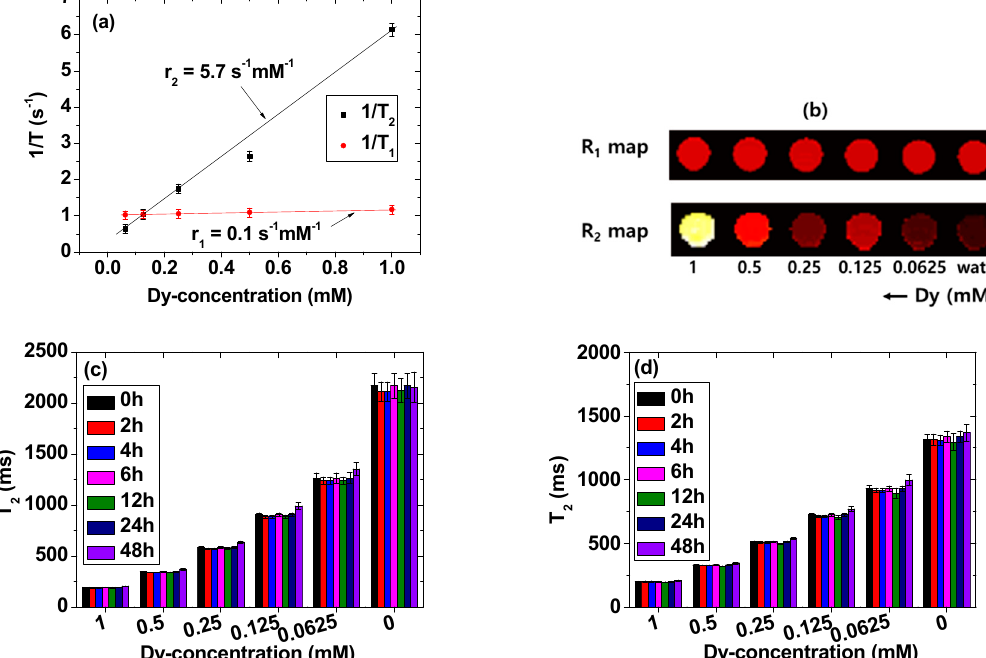
Figure 7. Relaxometric properties of the DYO@C nanoparticles in an aqueous solution. ( a ) Plots of 1/T 1 and 1/T 2 as a function of Dy-concentration in the 3.0 T MR field and the slopes correspond to r 1 and r 2 values, respectively; ( b ) R 1 and R 2 map images as a function of Dy-concentration, showing dose-dependent contrast enhancements in the R 2 map images but not in the R 1 map images; and T 2 relaxation times overtime in ( c ) triple-distilled water and ( d ) a 10% FBS in RPMI1640 medium as a function of